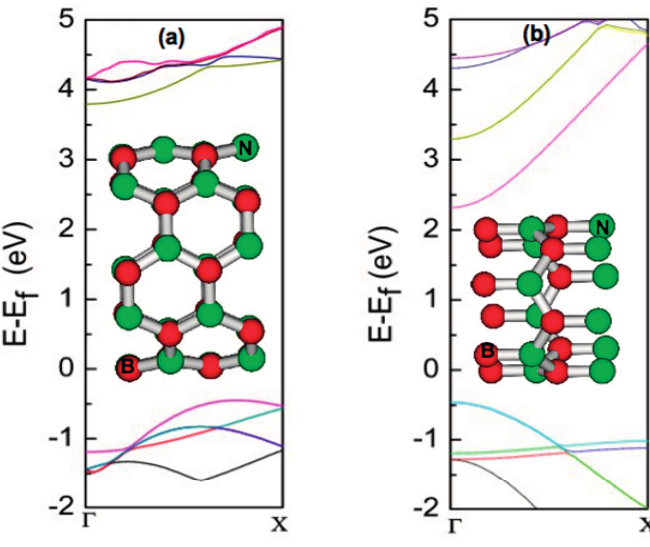
cell structures for (5, 5) and (6, 0) BNNTs are shown in the insets of Figure 2a and 2b, respectively. In the zigzag case, the minimum energy point in the conduction band and the maximum energy point in the valence band appear at the same Γ -point (direct band gap). In contrast, for the armchair tube, the valence band maximum shifts away from the Γ point leading to an indirect band gap. Band structures are calculated by using density functional theory; the generalized gradient approximation (GGA) with the PW91 functional for the exchange-correlation is used. The projected augmented wave (PAW) approach is used